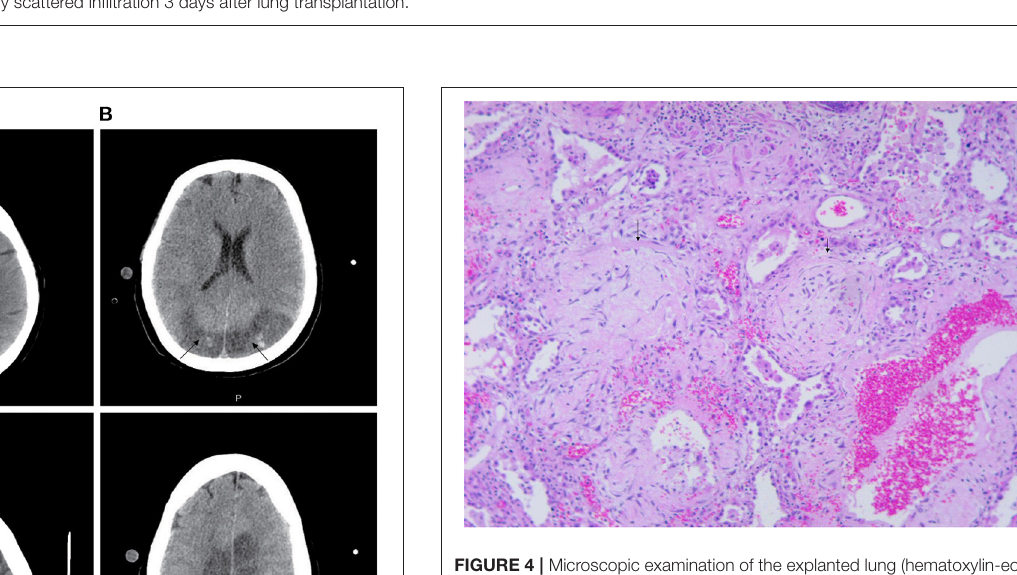
FIGURE 2 | Computed tomography (CT) image of the chest. (A) CT of the chest shows bilateral ground glass opacities 9 days before intubation. (B) CT of the chest shows bilateral pulmonary patchy infiltrates, which was considered as interstitial pneumonia 3 days before intubation (arrowheads). (C) CT of the chest shows bilateral pulmonary extensive infiltrates and lobular interstitium thickness, which was considered as pulmonary fibrosis 23 days after ECMO (arrowheads). (D) CT of the chest showed bilateral pulmonary scattered infiltration 3 days after lung transplantation.